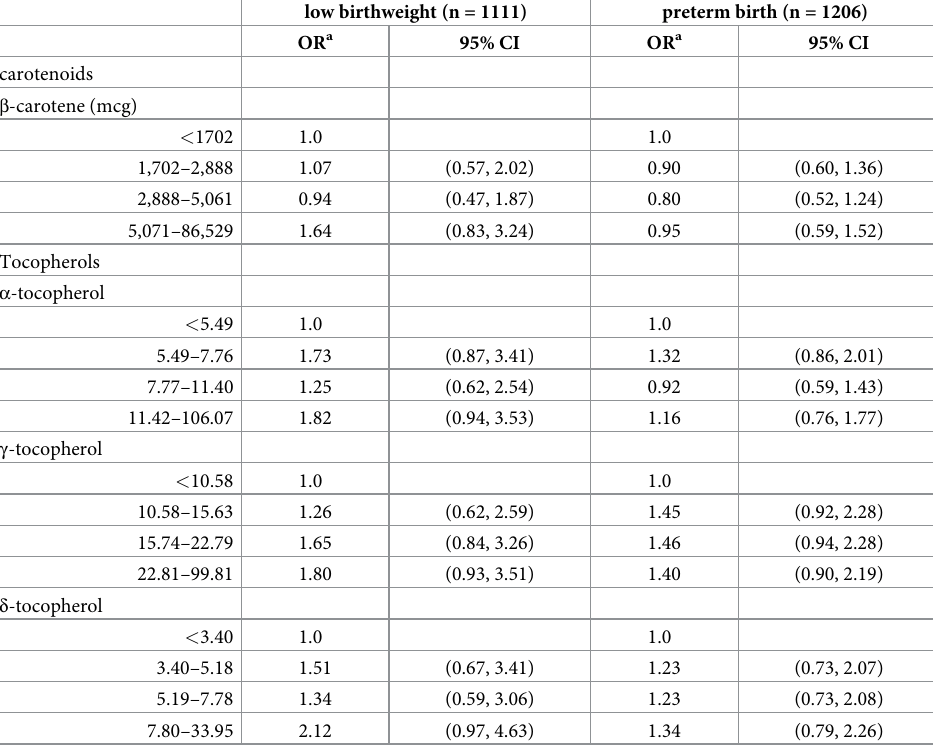
Table 6. Relationship between dietary intake of antioxidants and subsequent birth